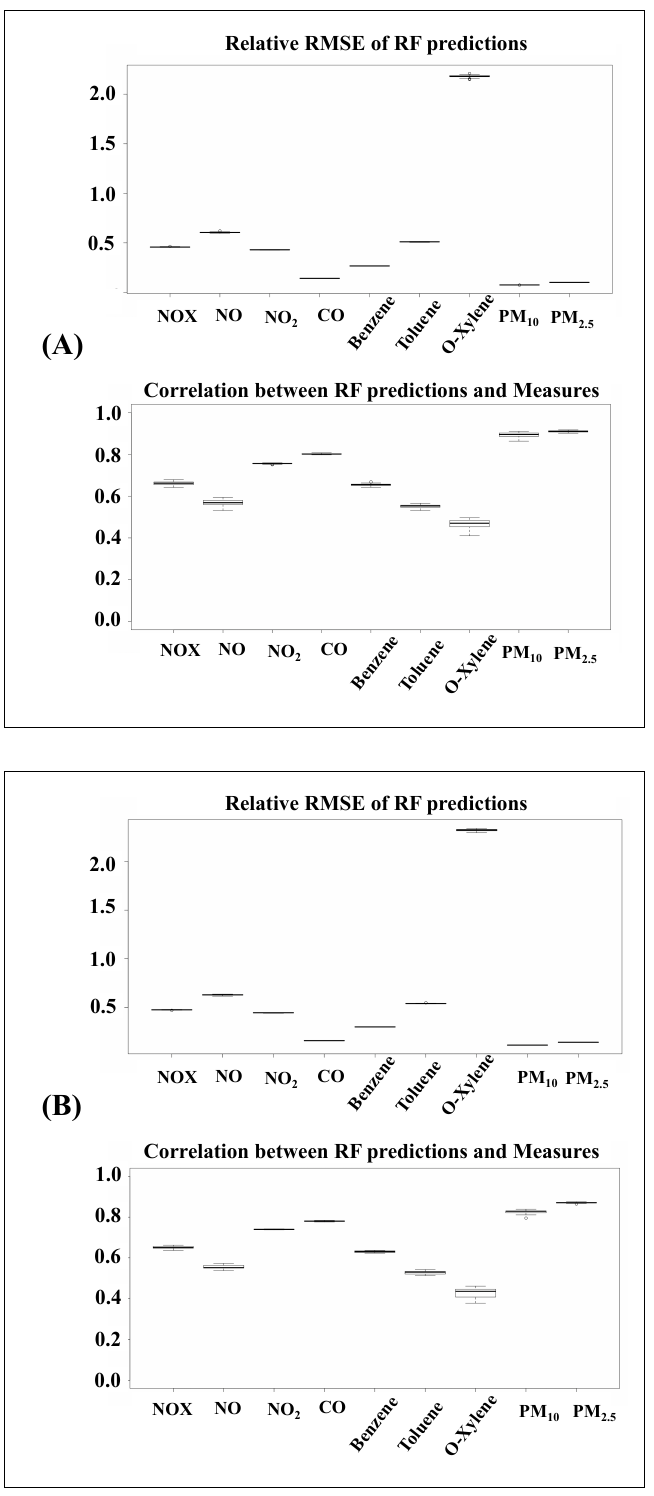
Figure 7. Distributions of the relative RMSE (top) and Pearson’s correlation coefficient (bottom) for each RF model using the WRF prediction for the third day (+72) on the lower resolution domain d01 ( A ) and on the higher resolution domain d02 ( B